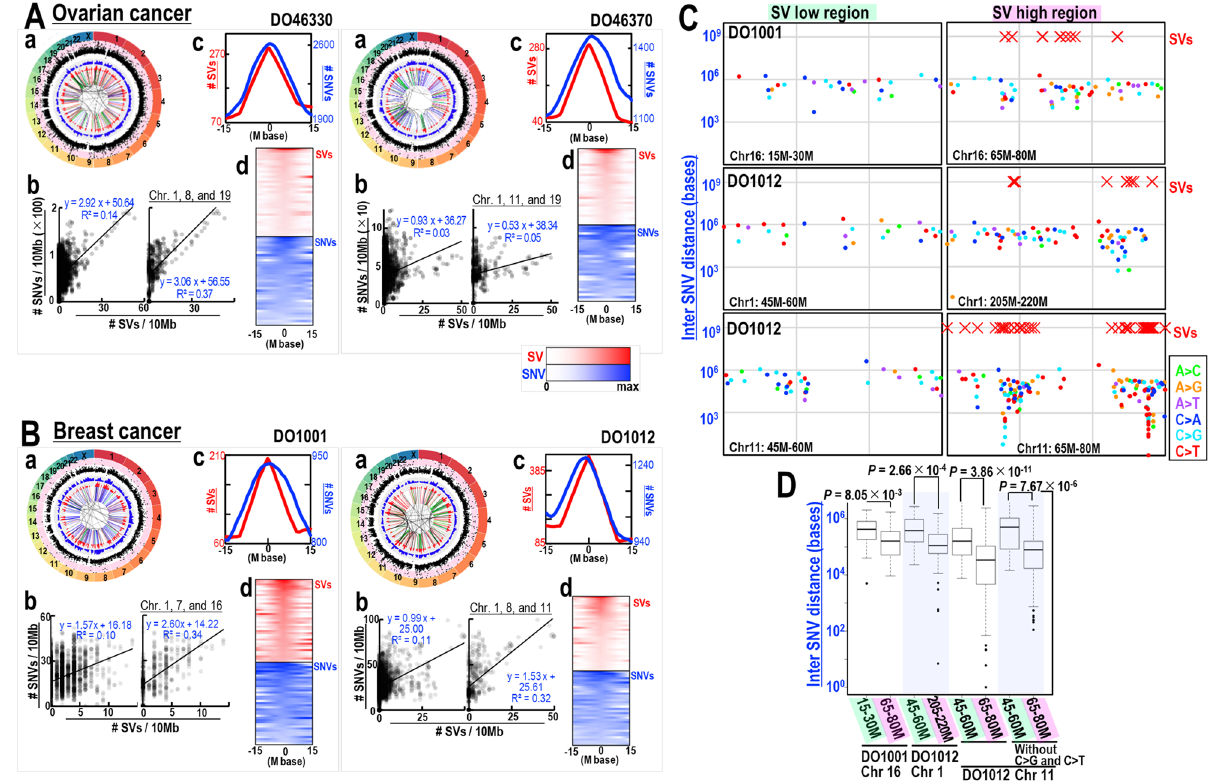
Figure 4. Echoed induction of SVs and SNVs in individual breast and ovarian cancers. ( A , B ) SVs and SNVs induced in two individual ovarian ( A ) and two individual breast ( B ) cancers. SVs and SNVs in each tumor were first analyzed by Circos plots ( a ), with chromosome ideograms shown around the outer ring. The two inner circular tracks show numbers of SVs (red) and SNVs (blue), with the corresponding moving averages. Inner lines indicate duplications (blue lines), inversions (green lines), deletions (red lines), and translocations (black lines). SNVs are also shown by rainfall plots, with black dots within pink and white circular zones indicating inter-SNV distances of < 1 kb and 1 kb–1 Mb, respectively. Correlations of SV and SNV numbers in each tumor were plotted in 10 Mb windows ( b ). Sites at which both the SV and SNV signals were more than twofold higher than the means in the genome were further analyzed by superimposing SV peaks with the associated SNV status ( c ), as well as by aligning SV peaks and SNV status ( d ). ( C ) Rainfall plots showing inter-SNV distances in breast cancers DO1001 and DO1012 along with loci at which SVs were induced; SV-low and -high regions are shown. ( D ) Box plots showing inter-SNV distances comparing these distances in SV-low and -high regions. Statistical analyses by two-tailed Welch’s t